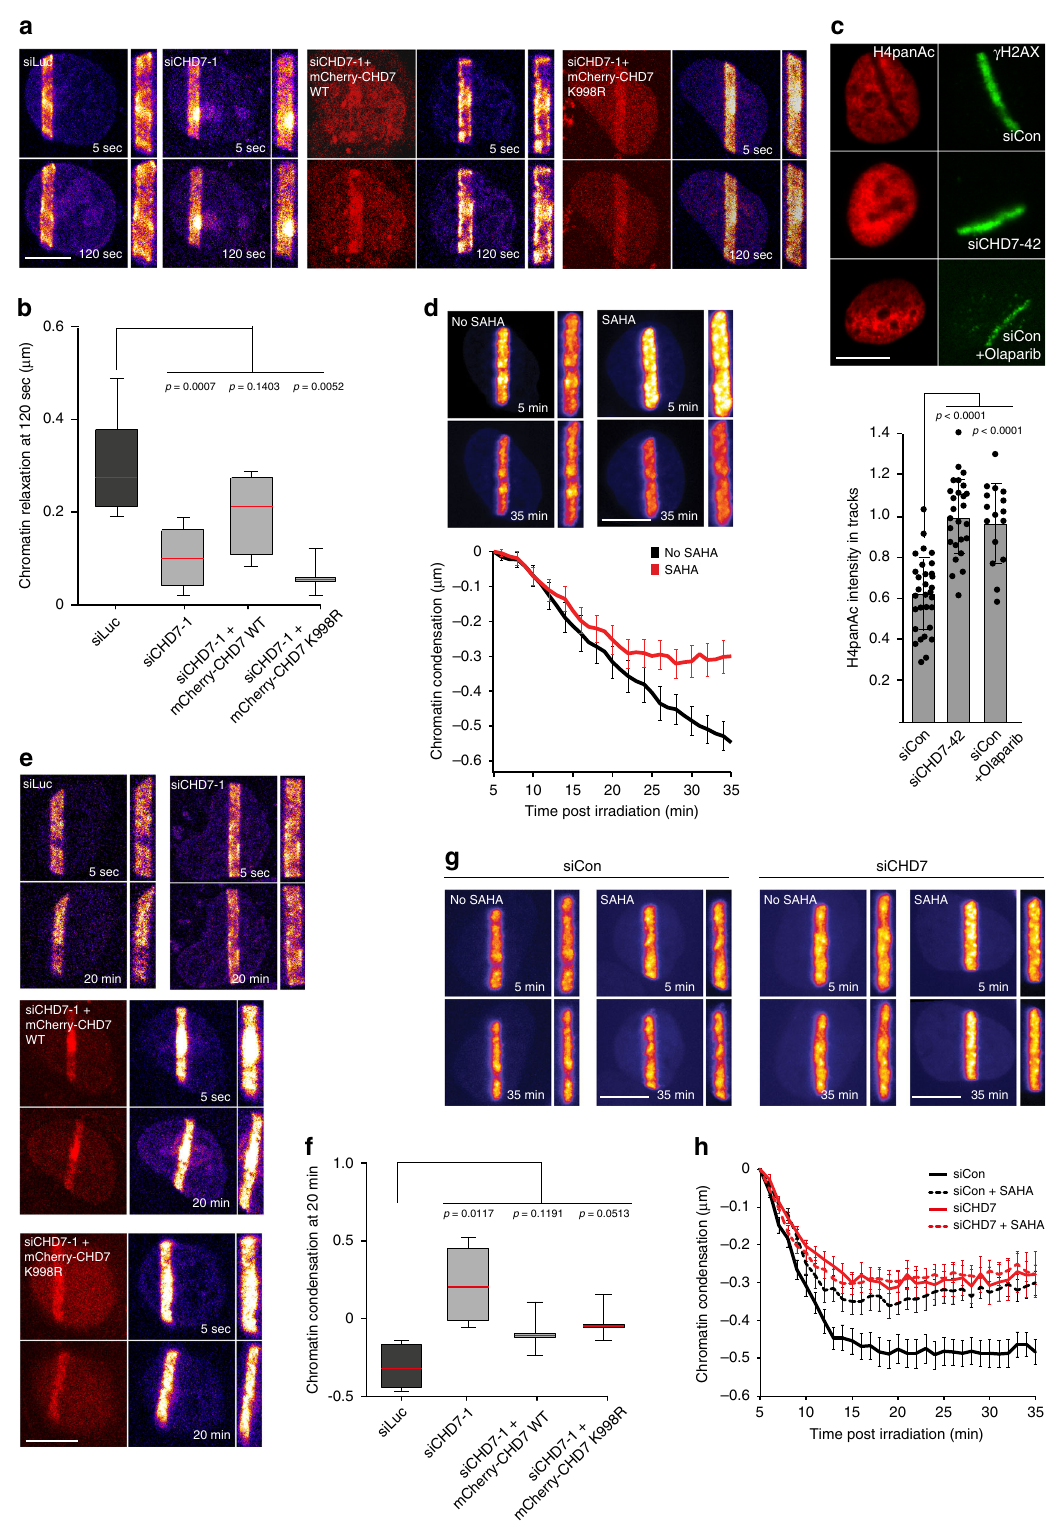
pmCherry-C1 respectively, and cloned as an Asc I fragment to generate pCDNA3.1- FLAG-His-EGFP-CHD7-WT or pCDNA3.1-FLAG-His-mCherry-CHD7-WT and pCDNA3.1-FLAG-His-EGFP-CHD7-K998R or pCDNA3.1-FLAG-His-mCherry- CHD7-K998R (Table 2). siCHD7-1-resistant CHD7 cDNA was generated by introducing the underlined mutations: GAAAATAAGGATAGCGAAAAG by polymerase chain reaction (PCR) and cloned as Not I /Xma I fragment into pCDNA3.1-FLAG-His-mCherry-CHD7-WT and pCDNA3.1-FLAG-His- mCherry-CHD7-K998R (Table 2). macroH2A1.1 cDNA was obtained